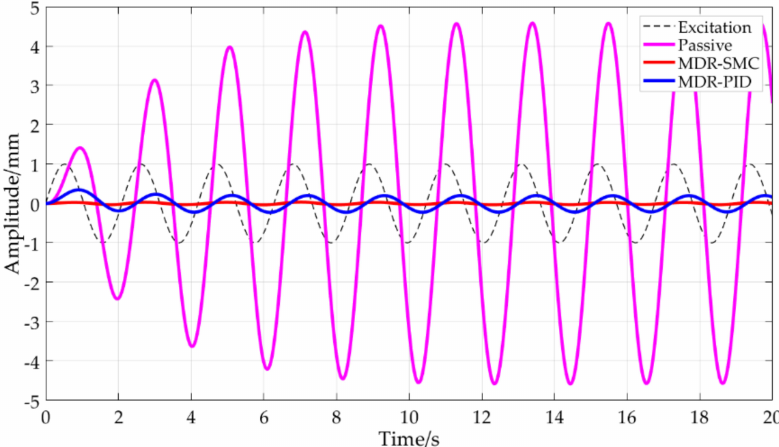
Figure 19. Comparison of the SMC with MRD, PID with MRD, and the passive system under excitation of a sinusoidal signal with an amplitude of 1 mm and a frequency of 3 rad/s.